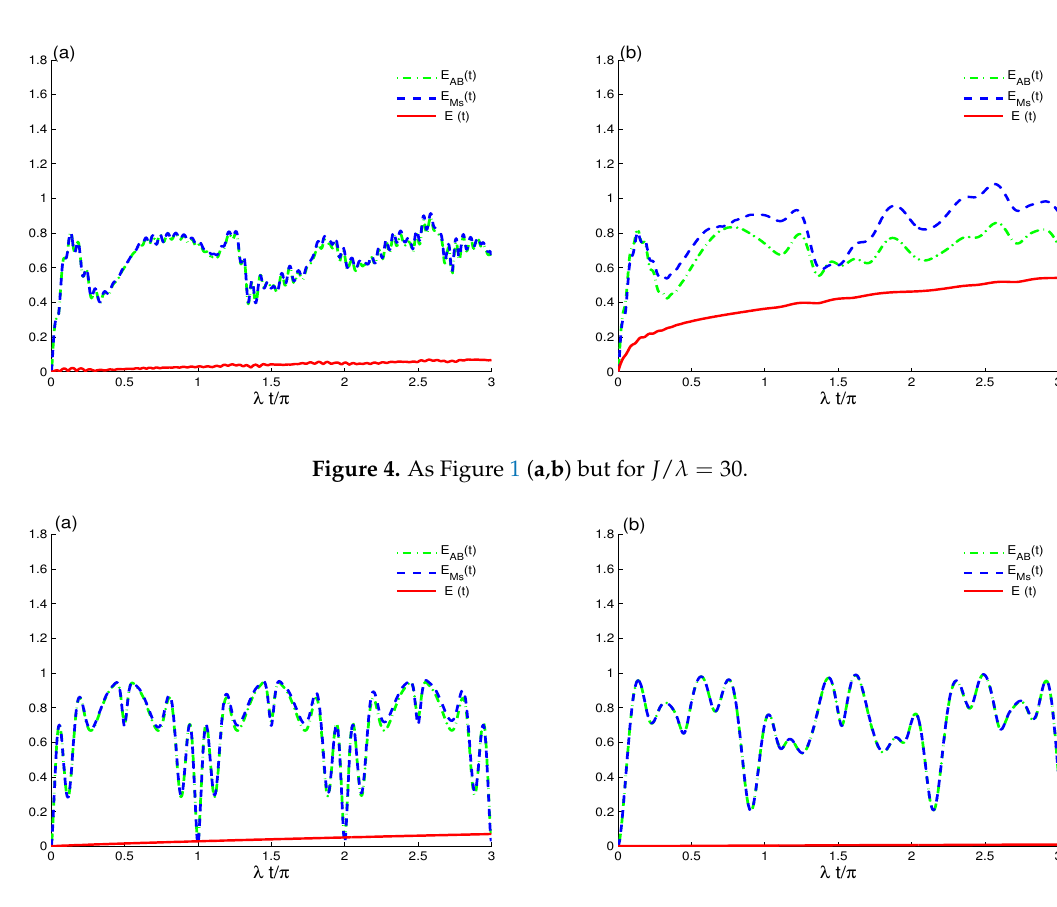
Figure 5. As Figure 3 ( a ) but for different cases: ( k , α ) = ( 1,5 ) in ( a ) and ( k , α ) = ( 1